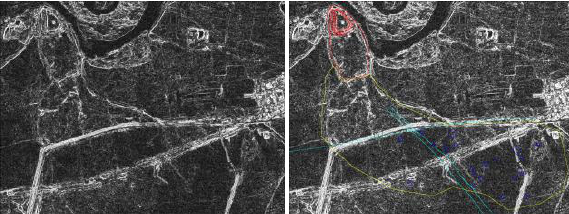
Figure 19a, b - A high pass 9x9 filter used on FORMOSAT-2 image of Kushaf site with an overlaid objects of interest on the left picture